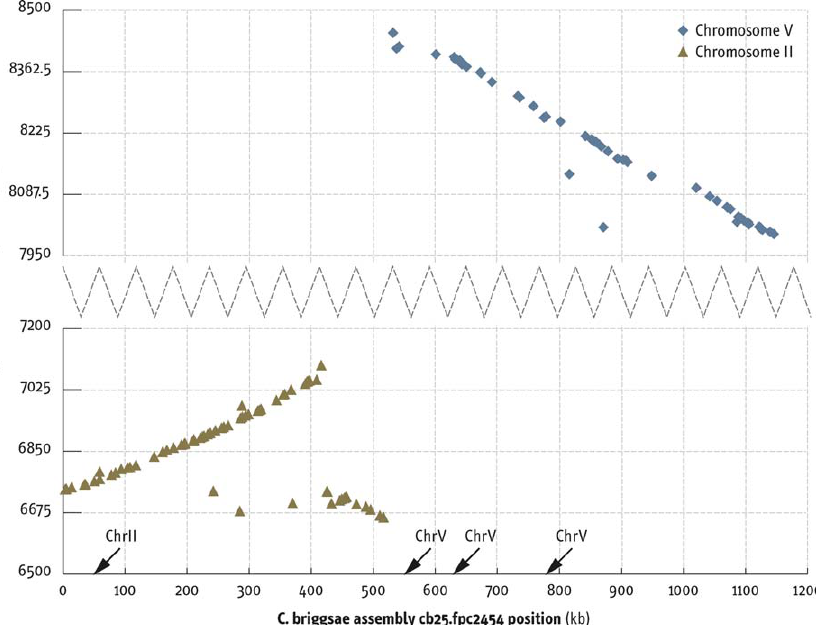
Figure 2. Example of the Transition in Synteny for an Assembly with Discrepant Genetic Markers For fpc contig cb25.fpc2454, the positions of 1:1 orthologs pairs are plotted both along the C. briggsae sequence ( x -axis) and the C. elegans genome sequence ( y -axis). The regions shown from two C. elegans chromosomes accounted for almost all of the orthologs from cb25.fpc2454. The positions of the SNP markers with their C. briggsae genetic map assignments are indicated along the x -axis. The region between the rightmost chromosome II ortholog at 524,614 and the leftmost chromosome V ortholog at 531,820 contained a single gap at 527,846 betweensupercontigs; the fpc contig was split at this